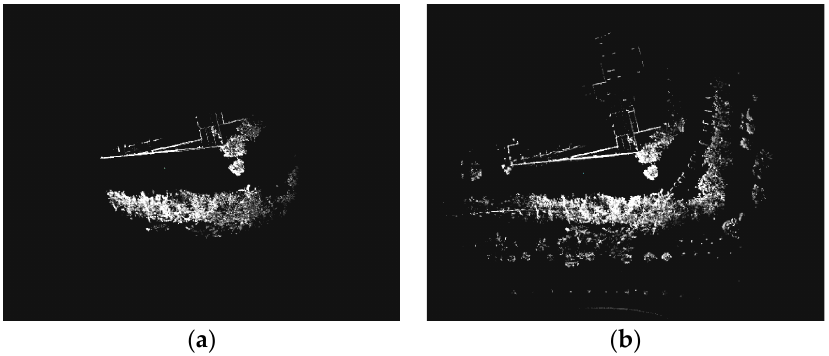
Figure 2. Sensor scan state with different distances: ( a ) LiDAR scan 25 m distances and ( b ) LiDAR scan 60 m distances.